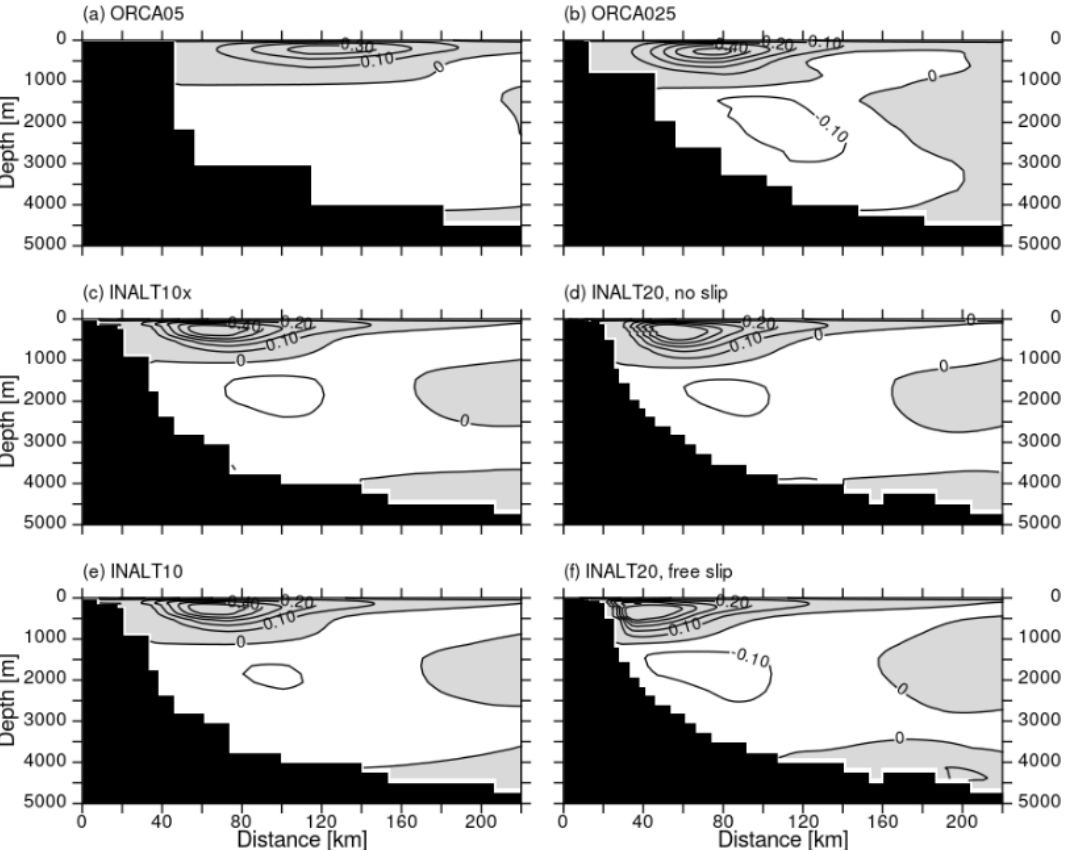
Figure 10. Mean (2000–2009) NBC structure at 11 ◦ S from ORCA05 (a) , ORCA025 (b) , INALT10x (c) , INALT20 NS_RW (d) , INALT10 (e) and INALT20 FS_RW (f) . Note that southwestward/negative velocities are shaded in white and northeastward/positive in grey; contoured are intervals of 10cms − 1